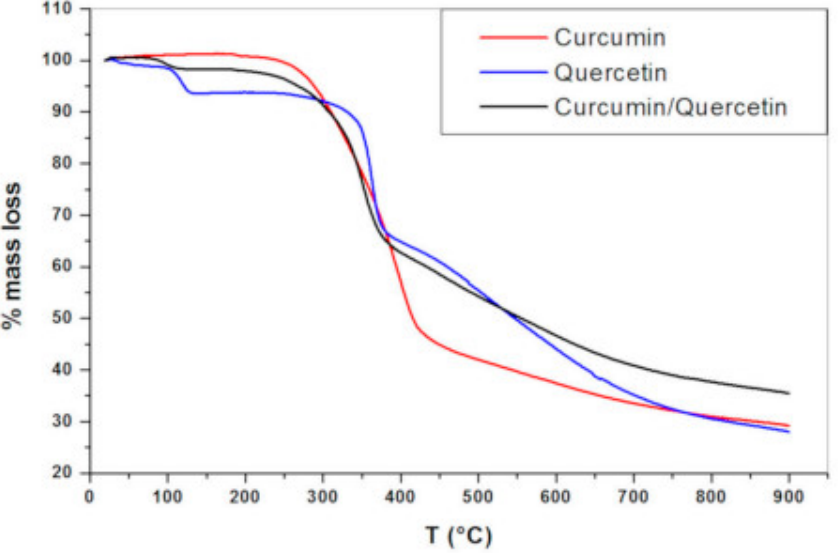
Figure 2. Analysis curve of thermogravimetric testing [28].